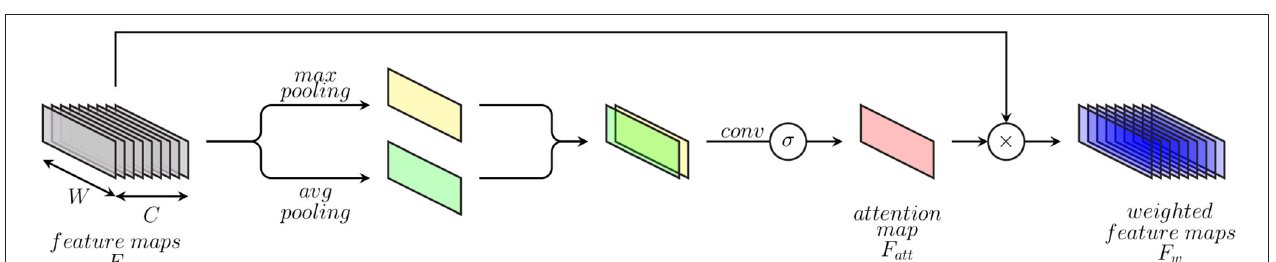
FIGURE 2 | Gating layer.